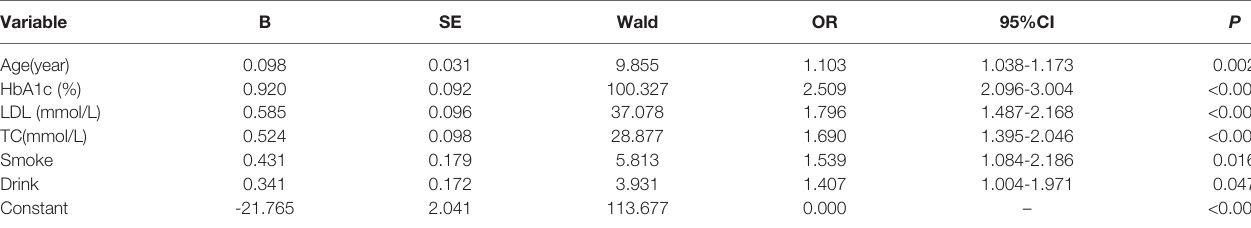
TABLE 3 | Multivariate logistic regression analysis of patients in the training cohort.